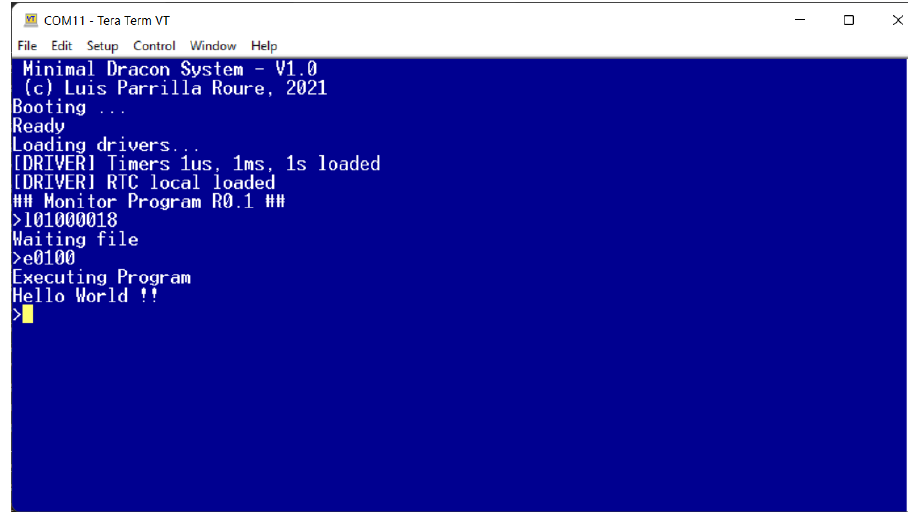
Figure 8. Hello World on